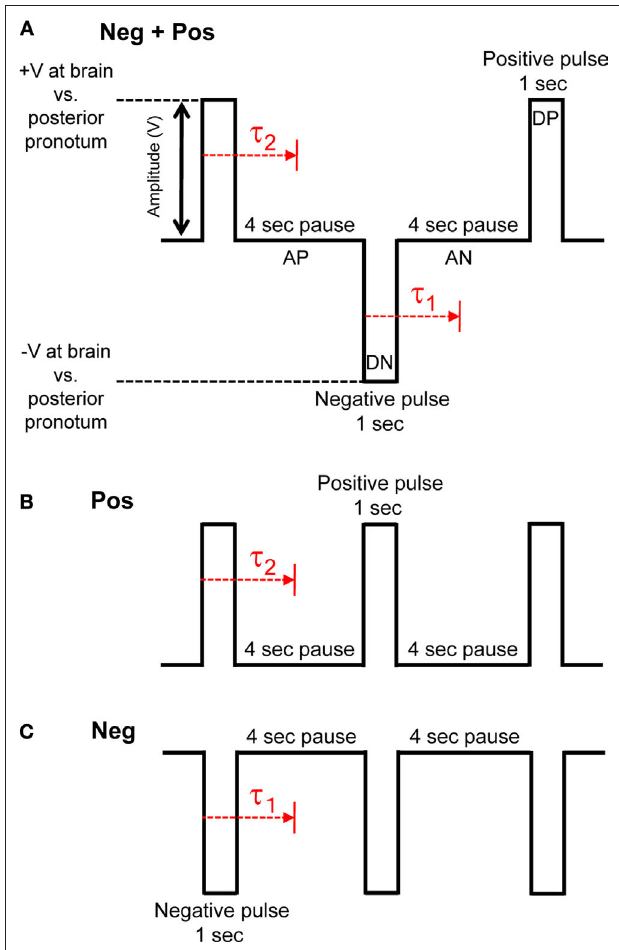
FIgure  | Three types of pulse trains (stimulus protocols) were investigated to elicit flight. (A) Neg + Pos: alternating 1 s duration positive and negative pulses, (B) Pos: 1 s duration positive pulses, (C) Neg: 1 s duration negative pulses. Pulse amplitude was swept from 0.1 to 5.0 V in 100 mV increments when testing for the amplitude threshold. Delay, τ is response time from beginning of positive or negative potential pulse to beginning of wing oscillation, respectively. See Table 1 in Supplementary Material for data on stimulated flight bouts in all tested Cotinis texana